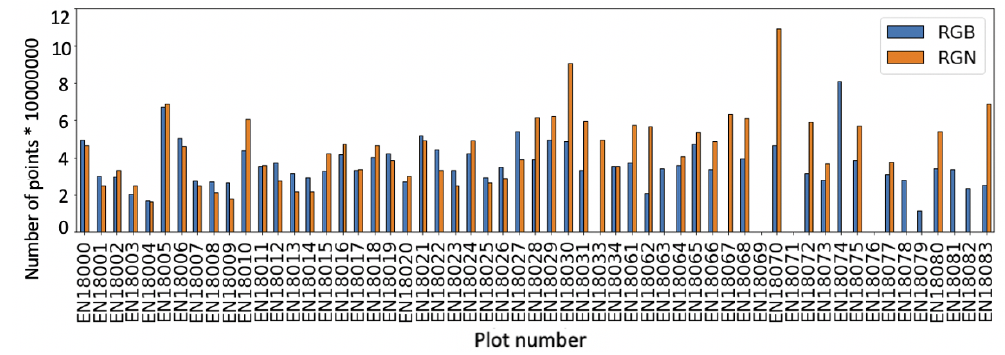
Figure 11. Comparison of the number of points in red–green–near-infrared (RGN; orange bars) and the combination of the two red–green– blue (RGB) “ groundonly ” and “ treesonly ” point clouds (RGB; blue bars).